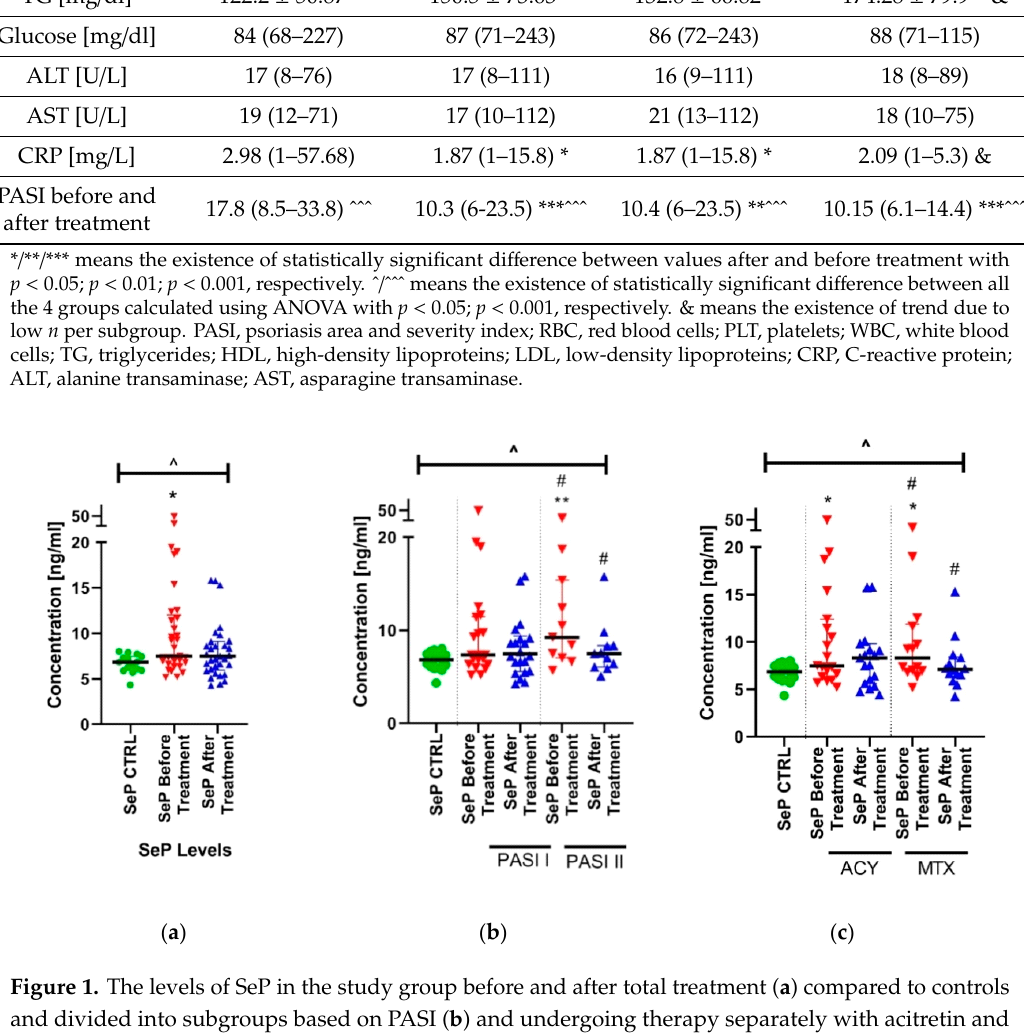
*/**/*** means the existence of statistically significant difference between values after and before treatment with p < 0.05; p < 0.01; p < 0.001, respectively. ^/^^^ means the existence of statistically significant difference between all the 4 groups calculated using ANOVA with p < 0.05; p < 0.001, respectively. & means the existence of trend due to low n per subgroup. PASI, psoriasis area and severity index; RBC, red blood cells; PLT, platelets; WBC, white blood cells; TG, triglycerides; HDL, high-density lipoproteins; LDL, low-density lipoproteins; CRP, C-reactive protein; ALT, alanine transaminase; AST, asparagine transaminase.